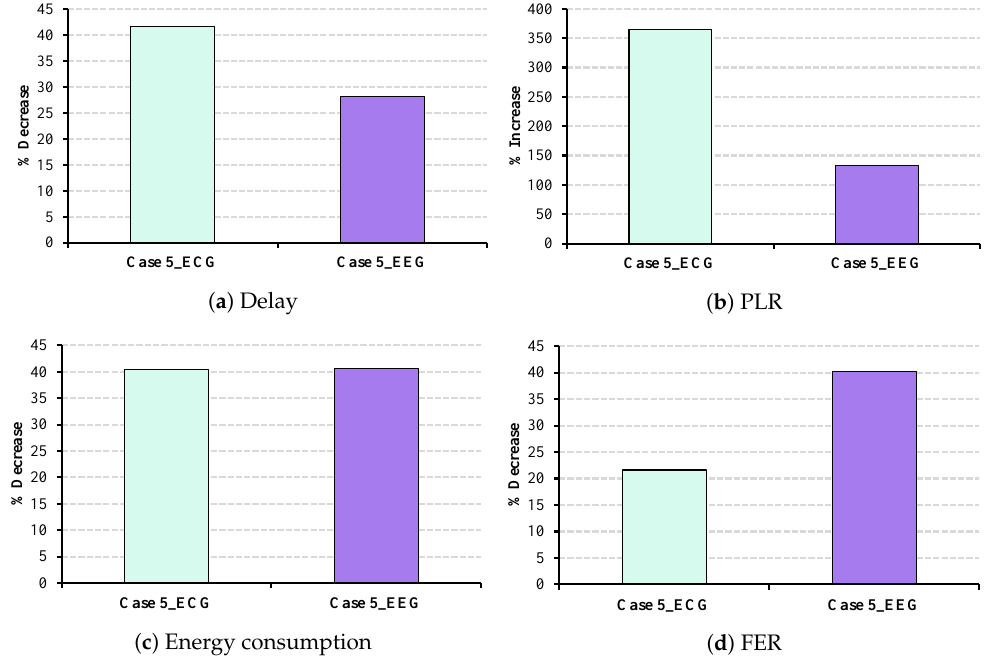
Figure 20. Desired QoS metrics and energy consumption under CW changes with sleep/wake- up mode.